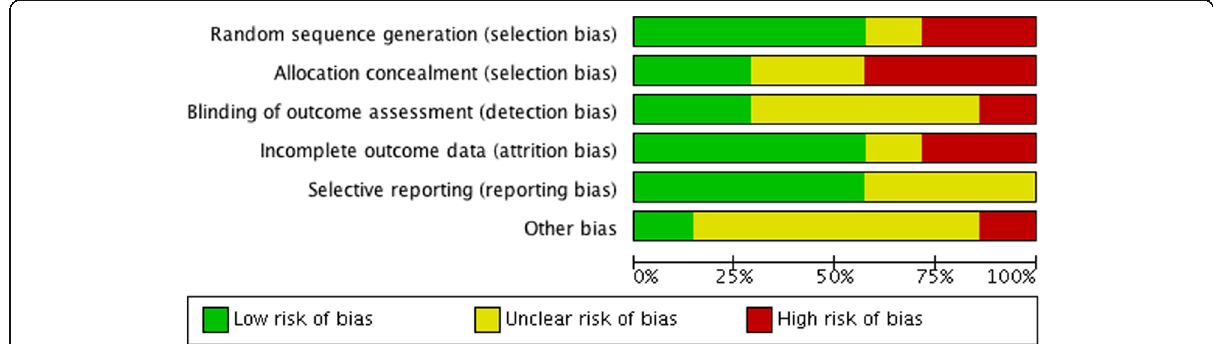
Fig. 2 Graphic visualization of the risk of bias judgements